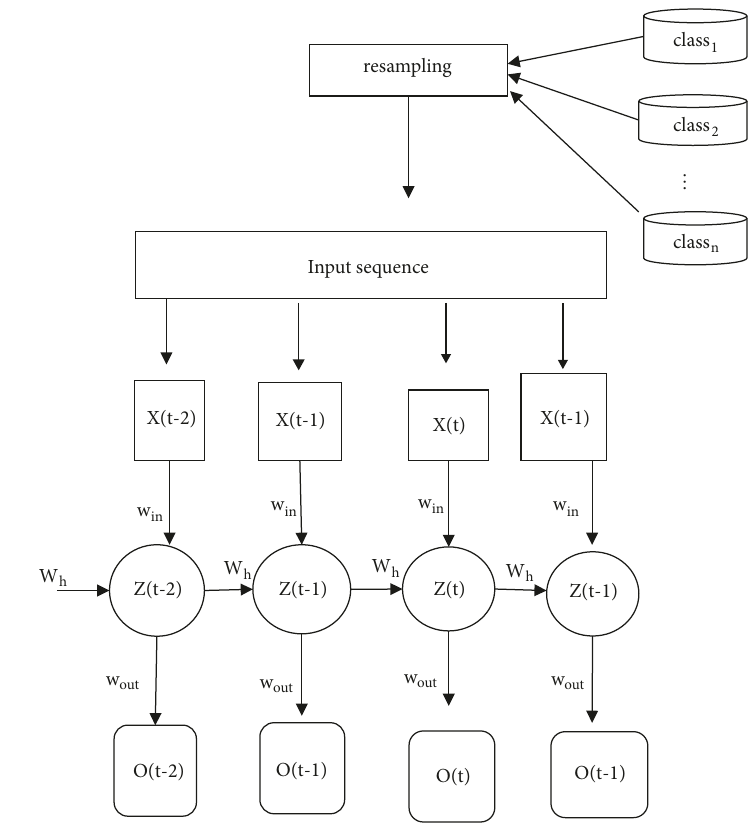
Figure 5: The architecture of